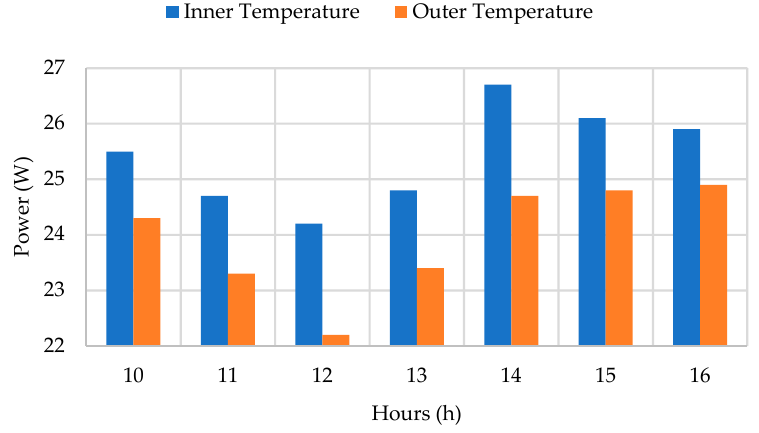
Figure 6. The inner and outer temperature of the water.